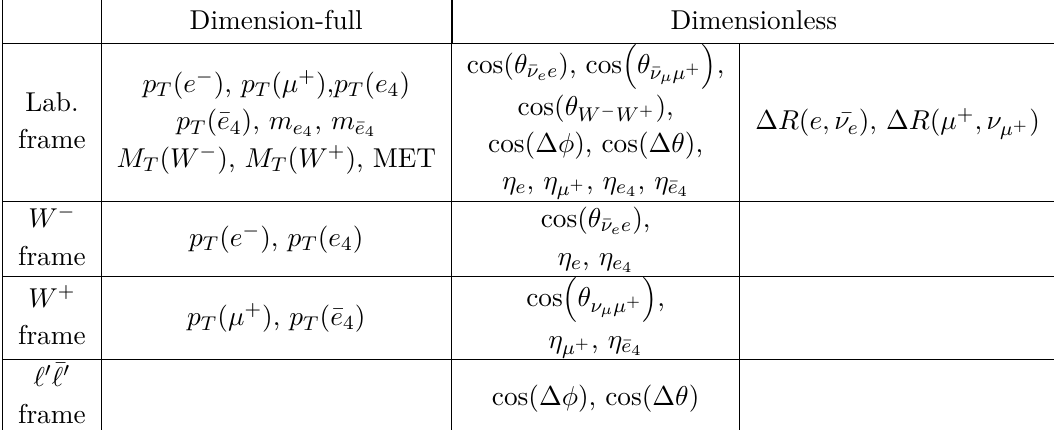
Table 4. Kinematic (dimension-full) and angular (dimensionless) observables selected to study the ZA and VBF channels. We include observables in four different frames of reference: laboratory frame (top row), W − rest frame (second row), W + rest frame (third row) and ‘ 0 ¯ ‘ 0 frame. θ the angle between the respective particles from either the final state or reconstructed objects. Note that ν is the reconstructed missing energy vector, following the discussion in section 3.